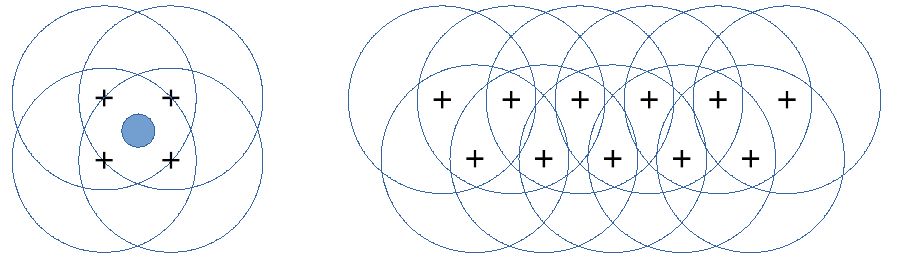
Figure 1. ( Left: ) Classical Wobble pointing mode, where the source is offset in the field of view. ( Right: ) Survey pointing mode, with observations overlapping with each other. The black “+” mark denotes the pointing direction for the various runs, and the blue circles the instrument field of